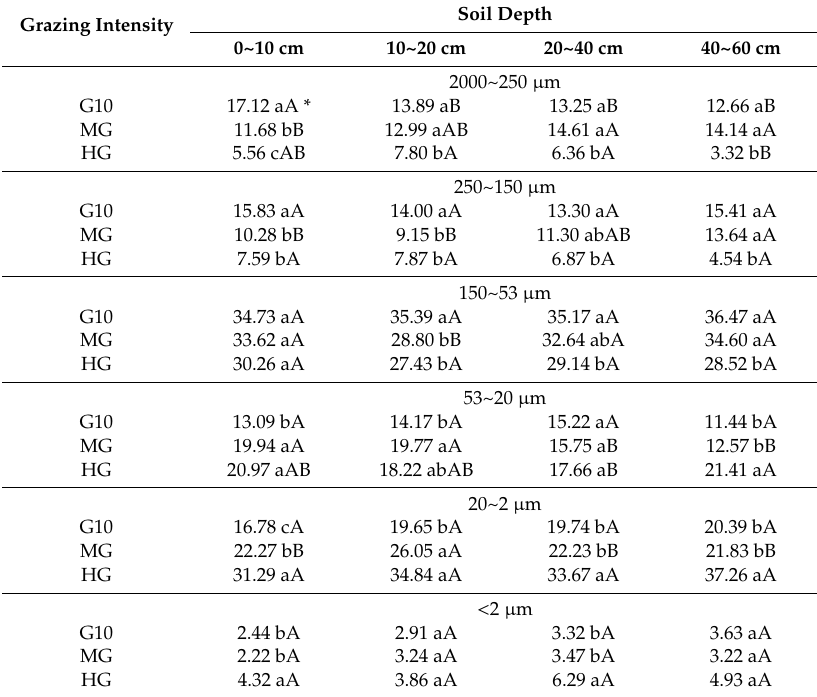
Table 1. The redistribution of soil particle sizes within soil layers under di ff erent grazing intensities. Grazing Intensity